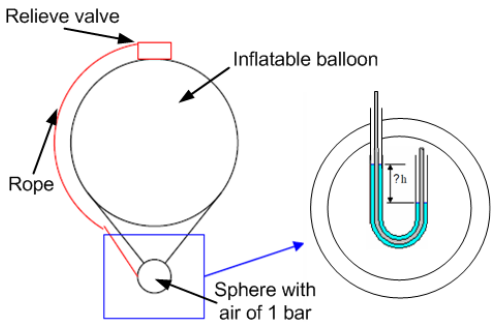
Figure 12. The inventive concept based on the principle of pressure